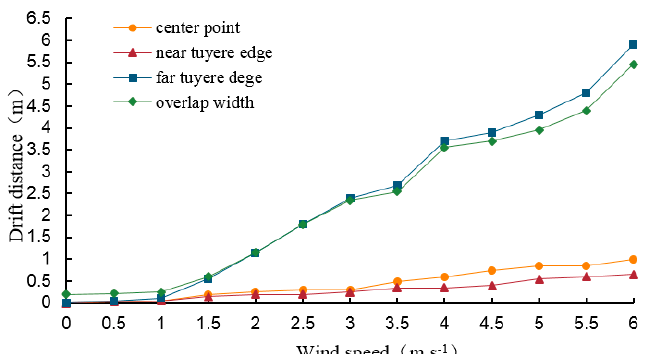
Figure 6. The relationship between wind speed and drift distance (center point, near tuyere edge, far tuyere edge, and overlap width).